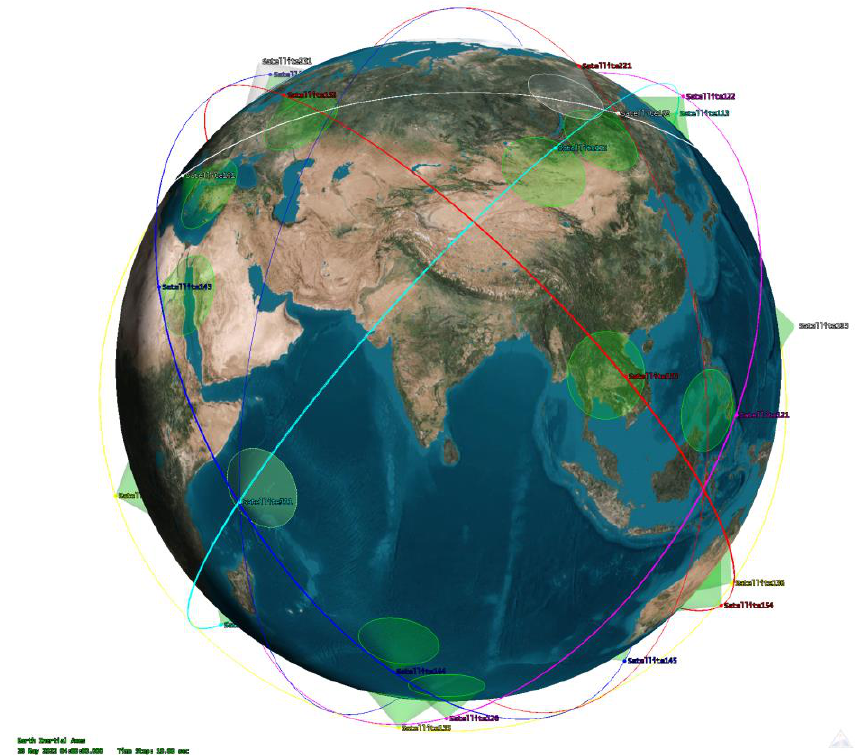
Figure 2. Hybird satellite constellation design.